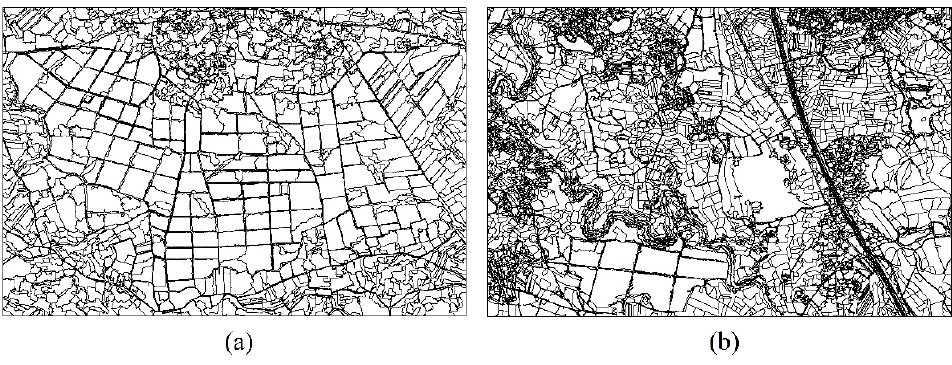
Figure 5. The segmentation results in Area 1 ( a ) and Area 2 ( b ).